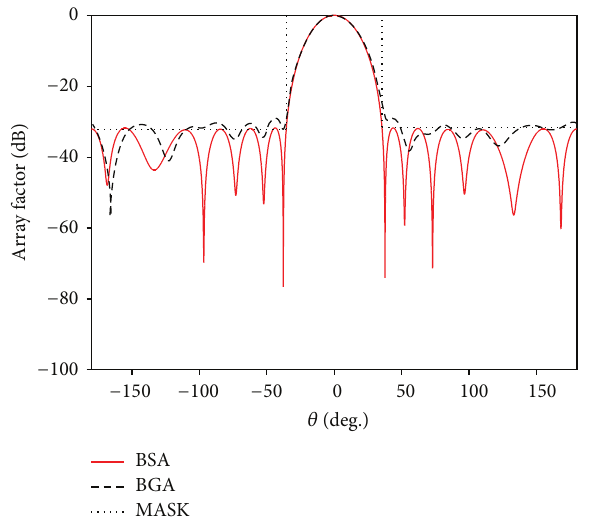
Figure 17: The radiation patterns obtained by BSA and BGA [3] for CCAA with central element .